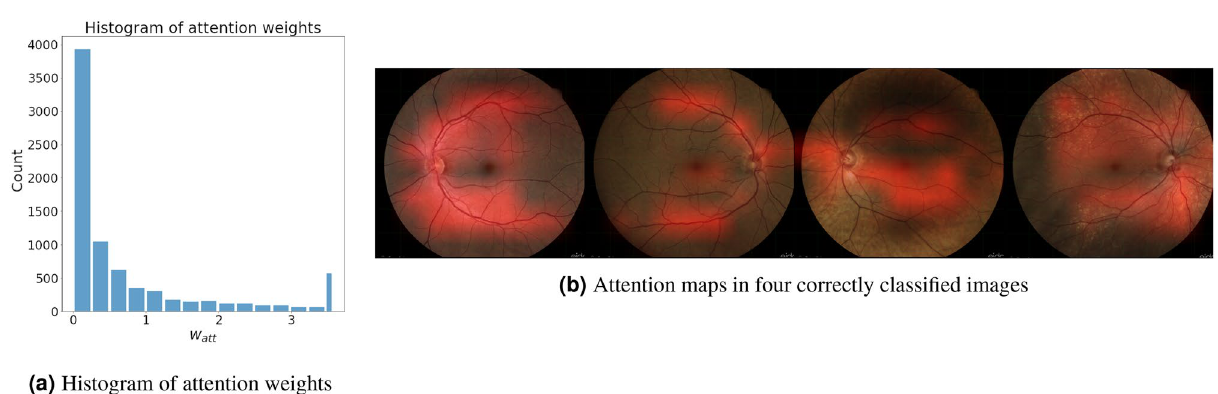
Figure 4. Subfigure ( a ) shows a histogram of all attention weights from the images in the validation set across all k-folds. It indicates that the network ignores many less relevant patches in the input images. All values above 3.5 are combined into the rightmost bar. Attention maps in Subfigure ( b ) correspond to four correct predictions of PAD. The first two images are true positives and the last two true negatives. The maps suggest that the network mostly relied on patches showing retinal vessels for the prediction.